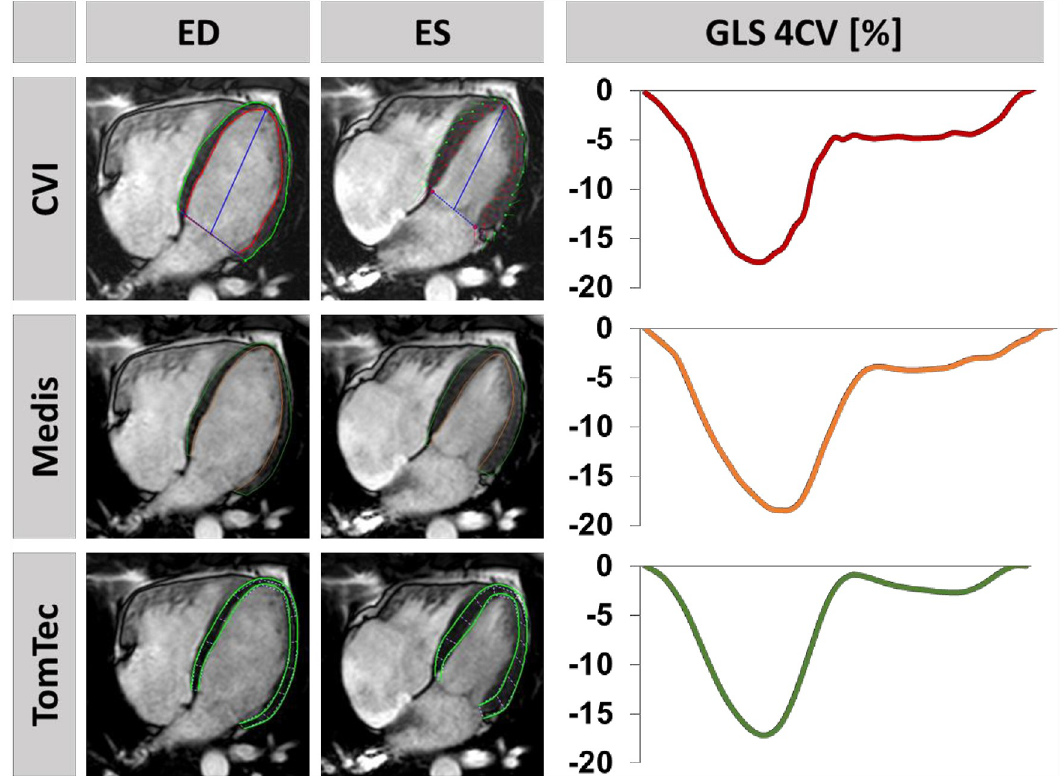
Fig 1. Feature-tracking using different software solutions. On the left, endo- and epicardially tracked borders of the left ventricle in a 4 chamber view (CV) at the end-diastole (ED) and end-systole (ES) are shown in a healthy volunteer using the different commercially available software solutions (upper row: CVI, middle row: Medis, bottom row: TomTec). On the right, the corresponding global longitudinal strain (GLS) curves are displayed.